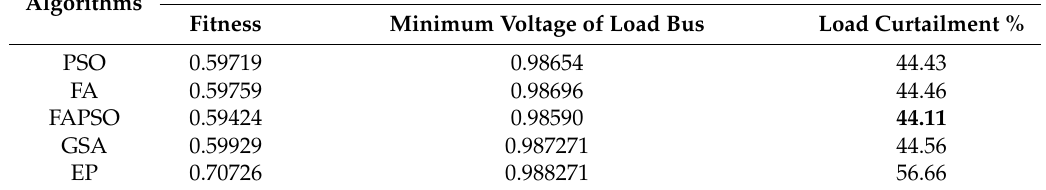
Table 5. Summary for comparison in performance of FAPSO, FA, PSO, GSA and EP in load shedding technique.